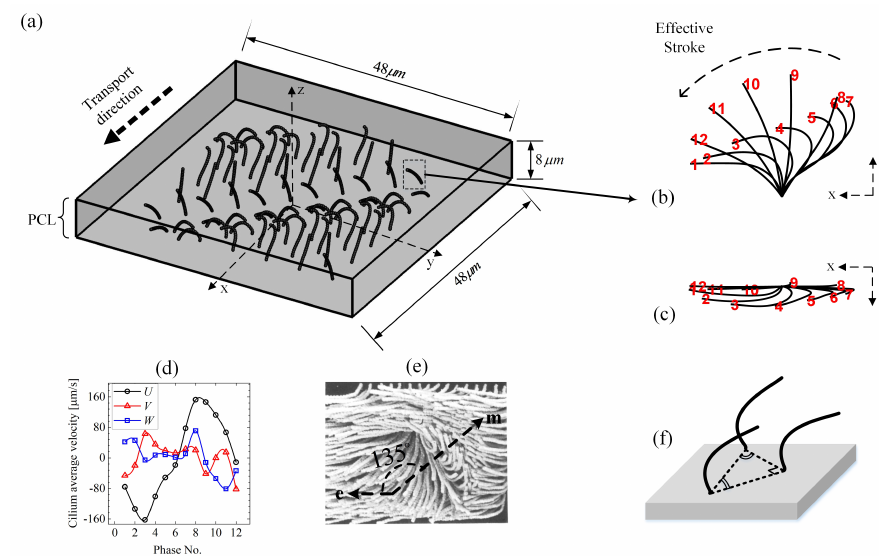
Figure 1. Model schematics. ( a ) Ciliary array of motile cilia beating within the periciliary liquid layer (PCL). ( b ) Side view and ( c ) top view of beating kinematics of an individual cilium reported by Gheber and Priel [34], which shows the changes in shape of each cilium X = ( X 1 , X 2 , X 3 ) at intervals of T /12 through one beat cycle (0 < t < T ). Cilia move in a planner motion during their rapid effective stroke (phase No. ∼ 1–7 ), but the recovering cilia (phase No. ∼ 8–12 ) are not performing a planner beat. When viewed from above, the ciliary tips follow a anticlockwise oval path. ( d ) The cilium velocity components. ( e ) Interpretation of ciliary activity on cultured rabbit tracheal epithelium from the model of Sanderson and Sleigh [3]. Arrows e and m indicate the directions of effective stroke and metachronal wave, respectively. ( f ) Adopted ciliary pack for all the simulation cases unless stated